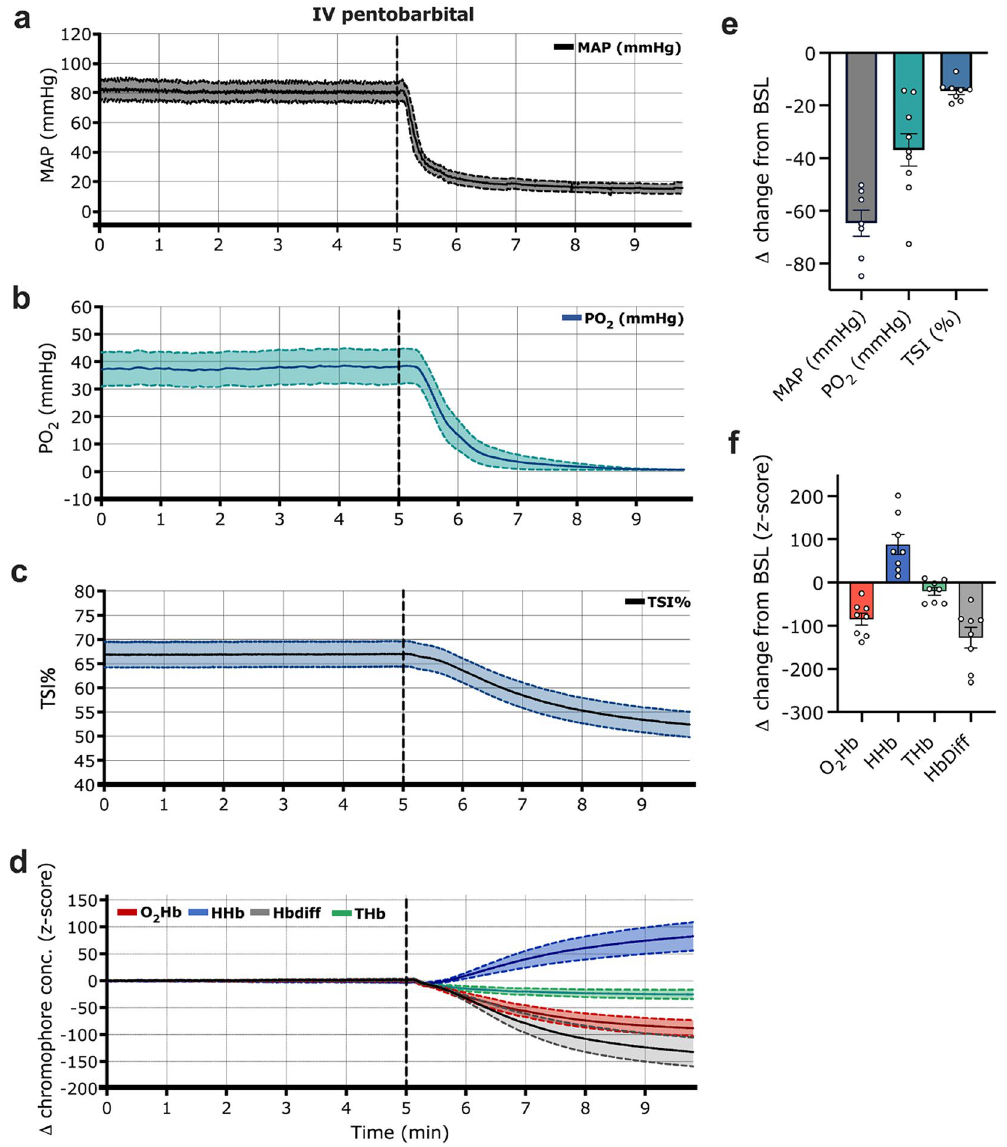
Figure 2. Transcutaneous NIRS, carotid blood pressure and spinal cord PO 2 responses to pentobarbital administration. Averaged traces from ( a ) MAP (n = 7 animals, ± SEM), ( b ) spinal cord PO 2, (n = 6, ± SEM), ( c ) TSI (%) (n = 8, ± SEM), and ( d ) relative changes in NIRS parameters of O 2 Hb, HHb, THb and Hbdiff (n = 8 ± SEM). The 5-min timepoint (dashed line) denotes the time of pentobarbital administration. ( e , f ) Delta changes to euthanasia relative to a 60-s pre-euthanasia baseline. TSI (%) tissue saturation index, Hbdiff hemoglobin difference, O 2 Hb oxygenated hemoglobin, HHb deoxygenated hemoglobin, THb total hemoglobin, MAP mean arterial pressure, PO 2 partial pressure of oxygen, BSL baseline, EUT